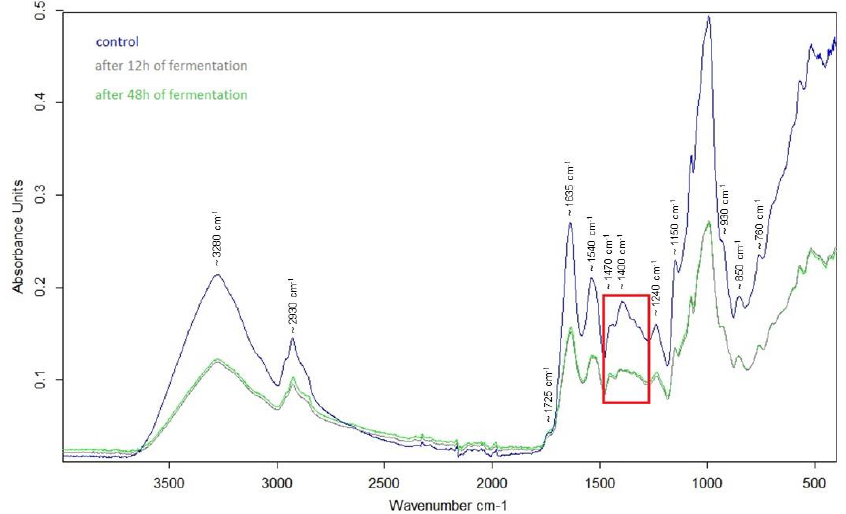
Figure 1. Comparison of the raw FT-IR spectra of the tested samples (the area of spectra in which the differences between fermented and control samples are the most noticeable is marked with a red rectangle).